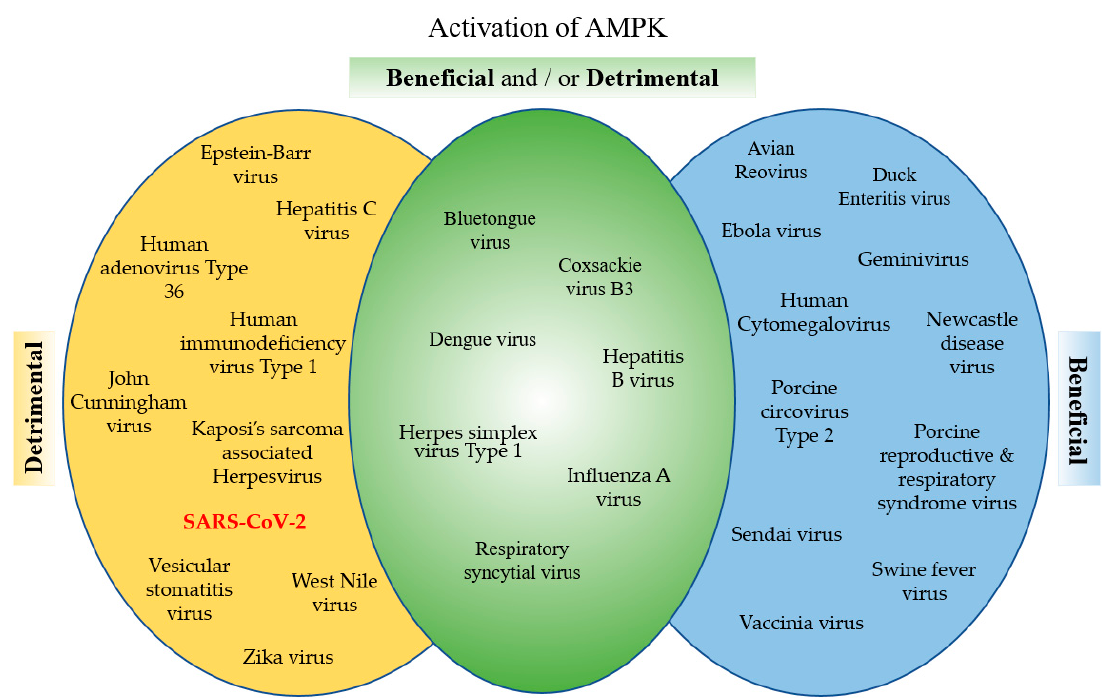
Figure 4. Categorizing viruses based on the effect of AMPK activation. Viral pathogens, sorted based on current literature, concerning whether activation of AMPK is beneficial or detrimental to the pathogens.